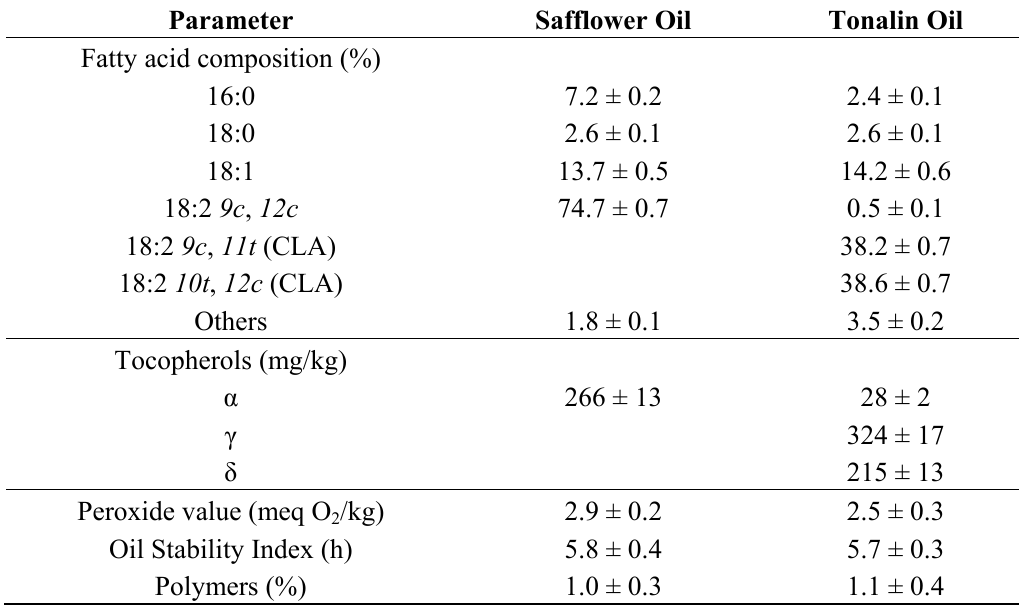
Table 1. Composition and oxidative parameters of Safflower and Tonalin ®